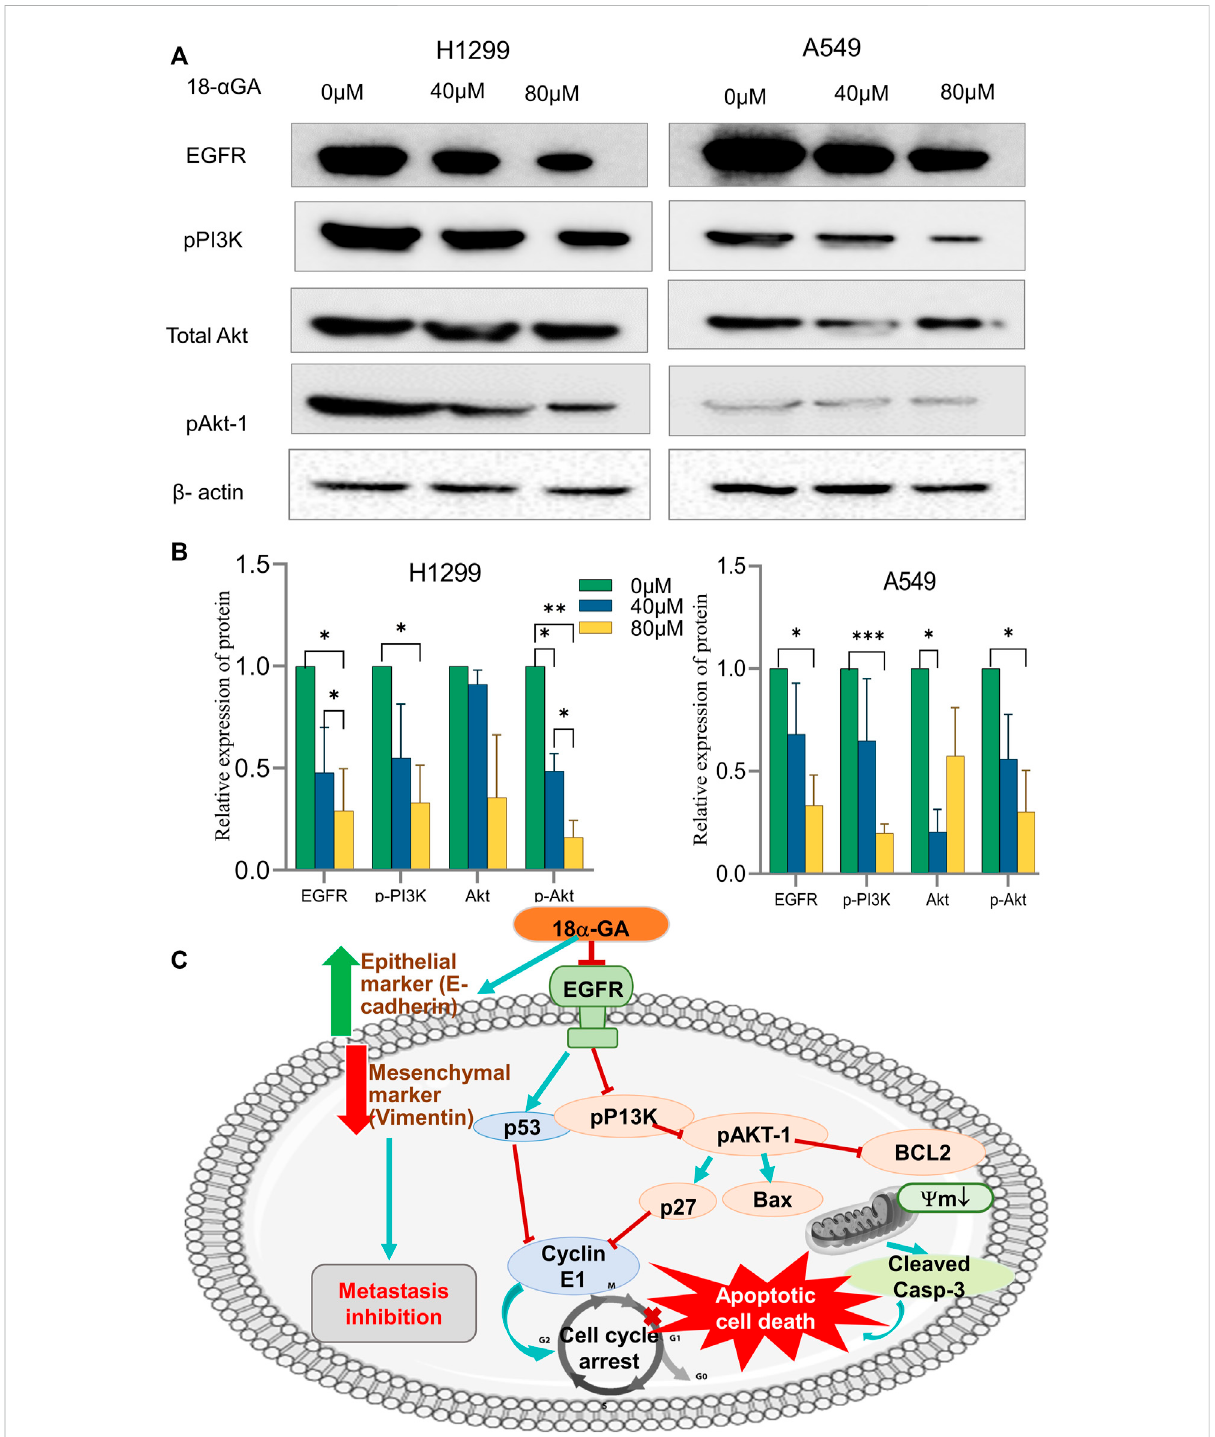
FIGURE 8 (A) Effect of different concentrations of 18 α -GA treatment on the protein expression of EGFR, pPI3K, pan-Akt and pAKT1 in H1299 and A549 cells. (B) Graph representing relative expression of protein with respect to beta-actin in treated and untreated groups, statistical analysis was done by 2-way ANOVA followed by Tukey ’ s Post-hoc multiple comparison test, * p < 0.05, ** p < 0.01, *** p < 0.001, **** p < 0.0001. (C) Depiction of the overall mechanism of action of 18 α -GA against NSCLC as predicted by combining key targets found in the bioinformatics and in-vitro